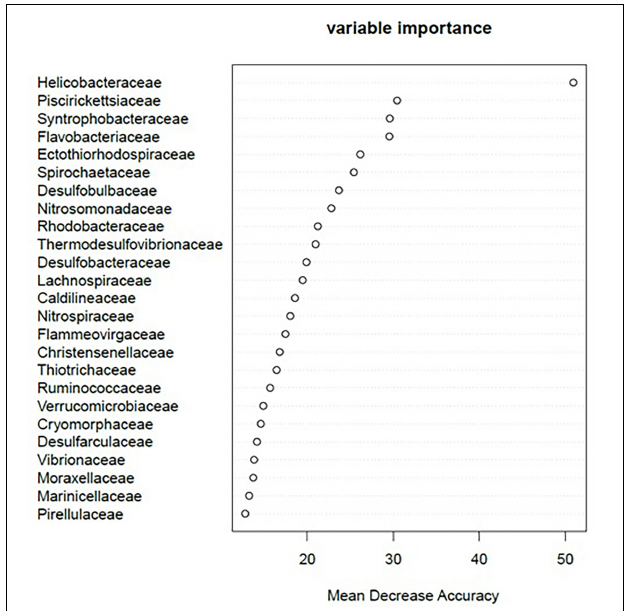
FIGURE 2 | Variable importance of the 25 most powerful bacterial families to predict the degree of aquaculture-related impact using random forest. The complete list of variable importance and corresponding Gini coefficient for each of the 88 bacterial families identified in this study is available as Supplementary File 4